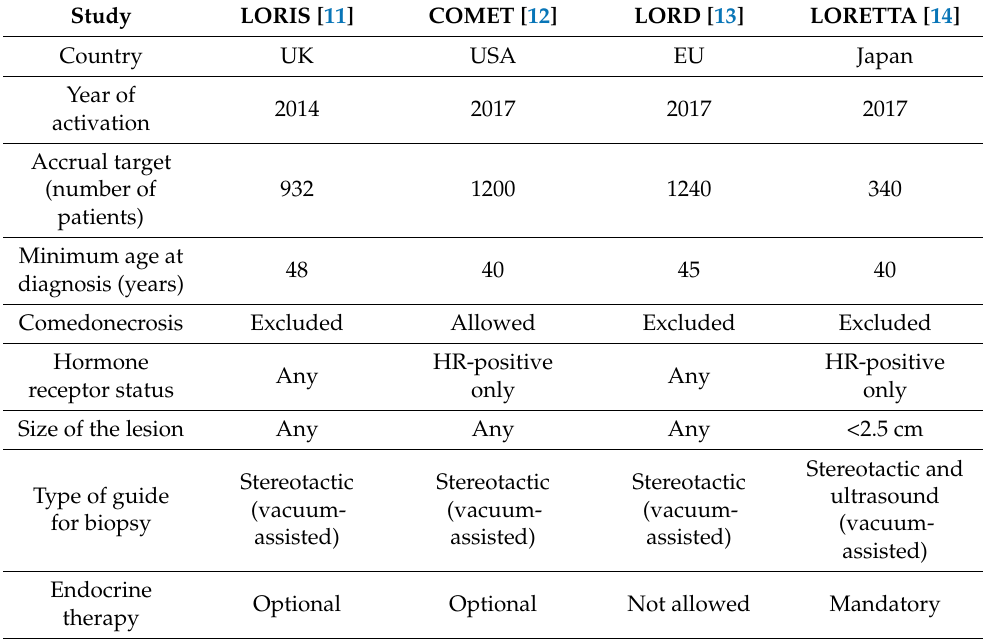
Table 1. Main aspects of the four prospective international study protocols (LORIS, COMET, LORD, and